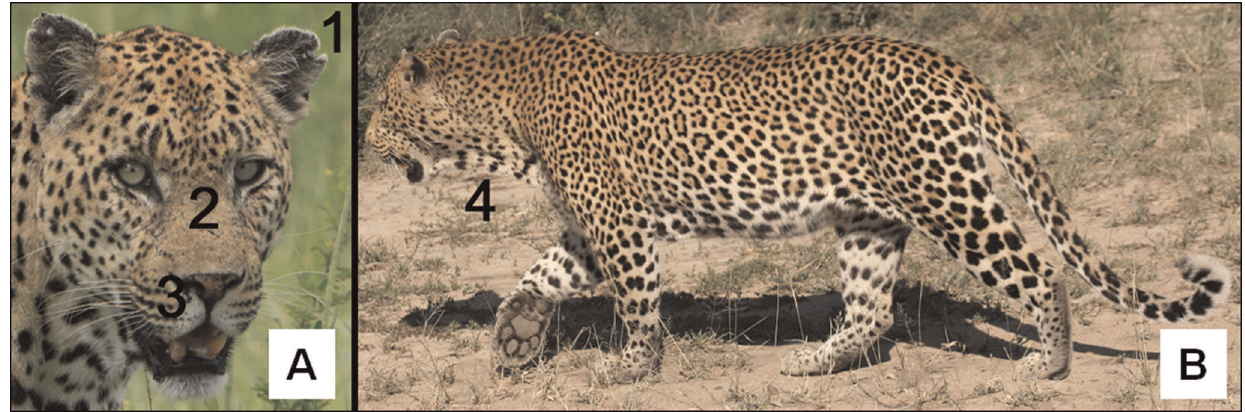
Figure 1. Photograph presentation types used in the survey to test sexing and aging ability. (A) Portrait photo of a 10.3-year male leopard showing the condition of the ears ( 1 ; score = 9), facial scarring ( 2 ; score = 3) and nose pigmentation ( 3 ; score = pink-spotted); (B) side- profile photo of a 7.5-year male showing dewlap size ( 4 ; score = 5) (photo credits: A. Bachelor).